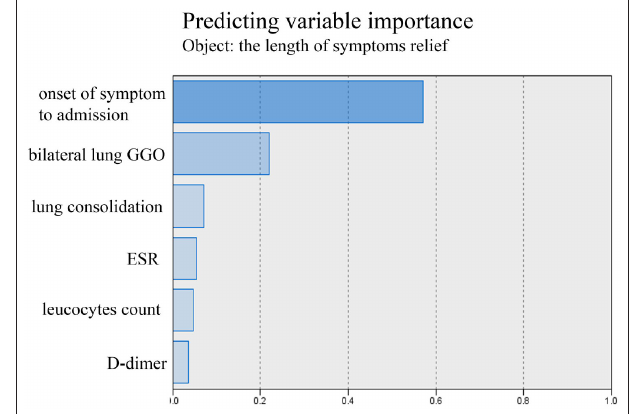
FIGURE 3 | Using automatic linear modeling to predict relevant factors of the length of hospitalization.